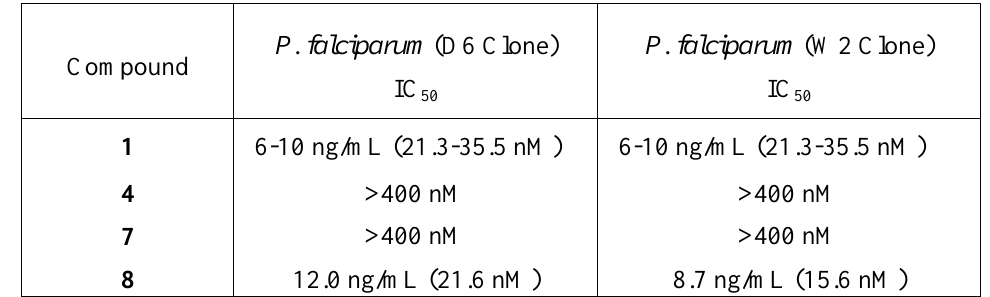
Table 1. Antimalarial activity of compounds 1 , 4 , 7 and